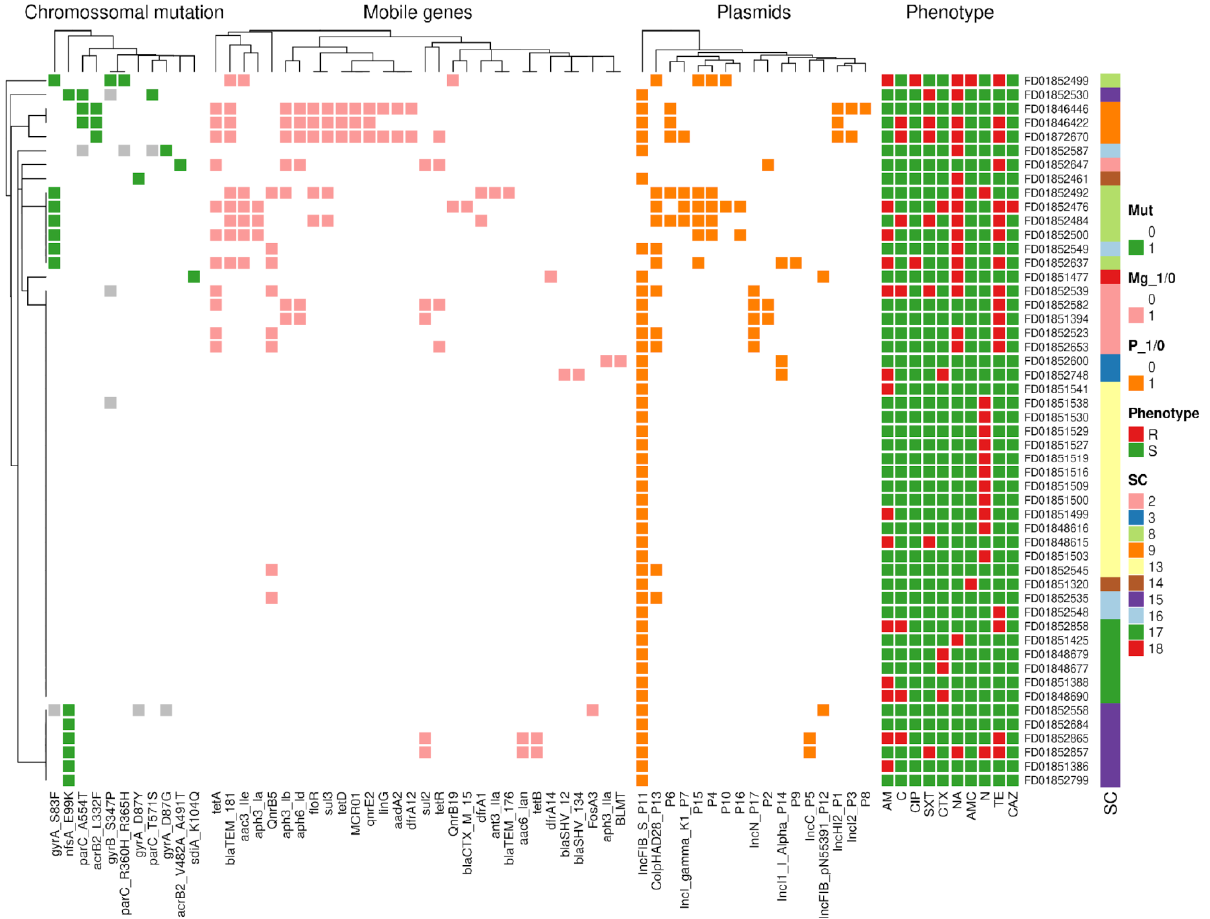
Figure 5. Heatmap showing presence and absence of antimicrobial resistance (due to chromosomal AMR gene variations, mobile genes, and plasmids), their corresponding phenotype, and sequence cluster classification in 50 Salmonella Typhimurium isolates.